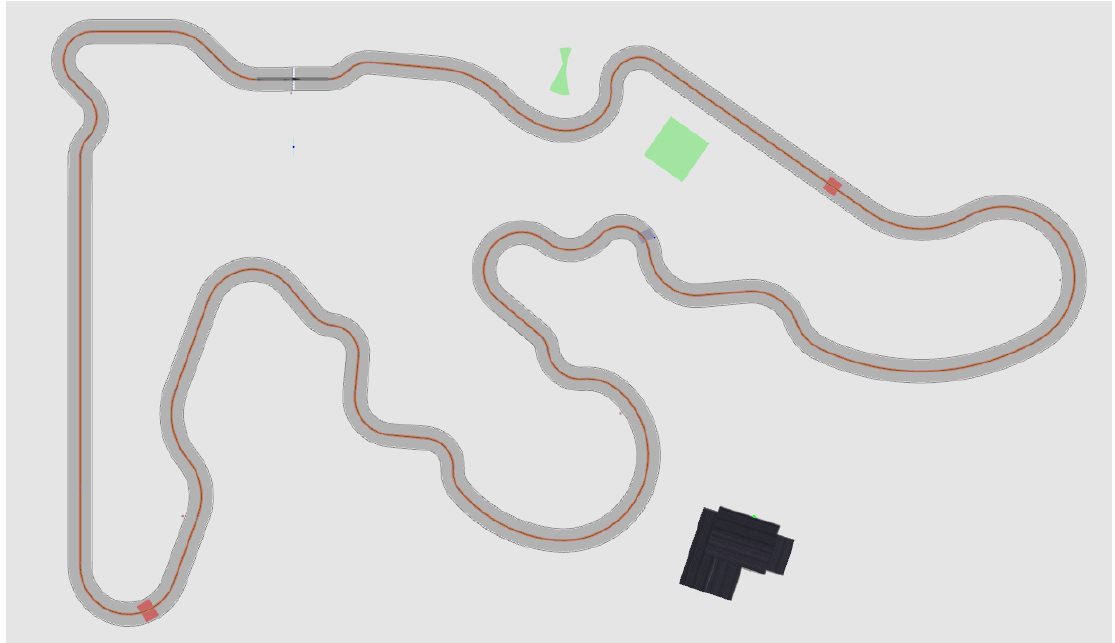
Figure 9. Hockenheim 2010 Formula Student Endurance track aerial view.